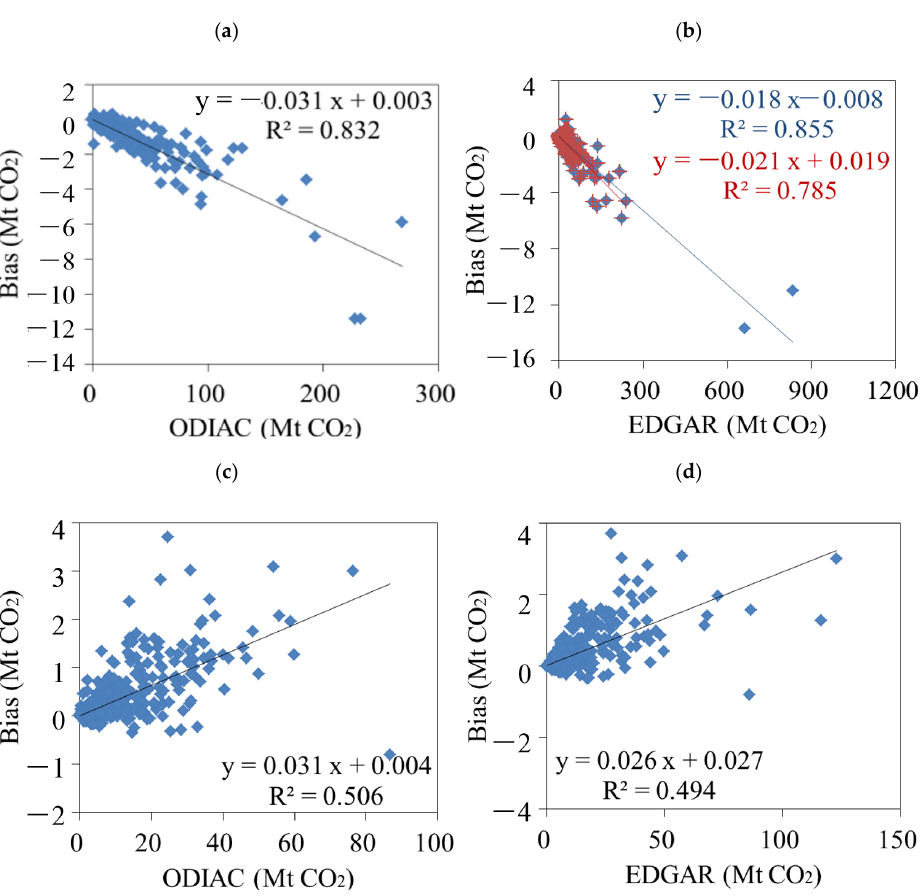
Figure 5. Scatter plots of the bias corresponding to the emissions in inventory in 2012: ( a ) ODIAC in China, ( b ) EDGAR in China where red color is the result excluding two grids with abnormal emis ‐ sions in the cities, Shanghai and Shenyang, ( c ) ODIAC in the USA, ( d ) EDGAR in the USA.